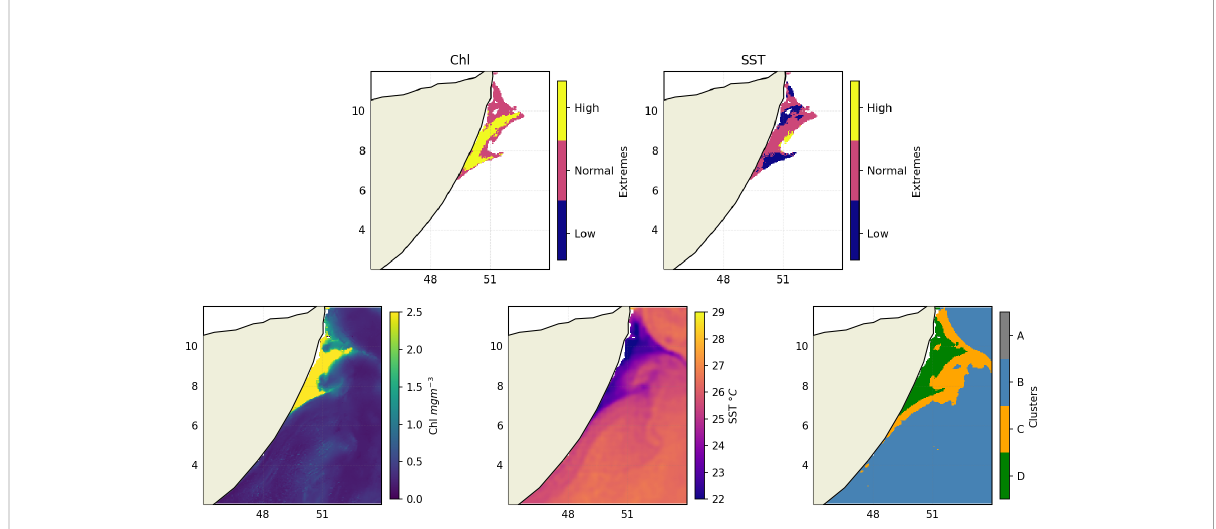
FIGURE 9 Example of extremes classi fi cation for (top left) Chl, (top right) SST, alongside the underlying variables: Chl (bottom left), SST (bottom centre), and upwelling classi fi cation (bottom